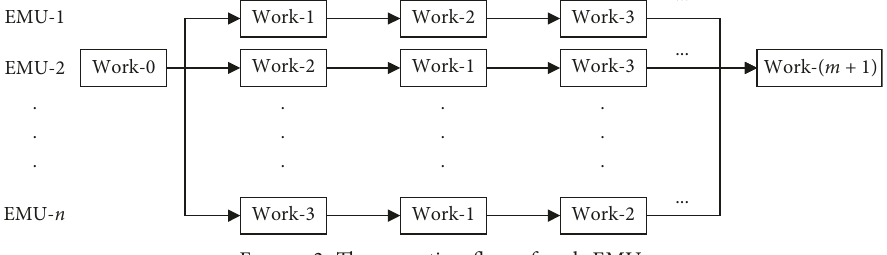
Figure 2: The operation flow of each EMU.